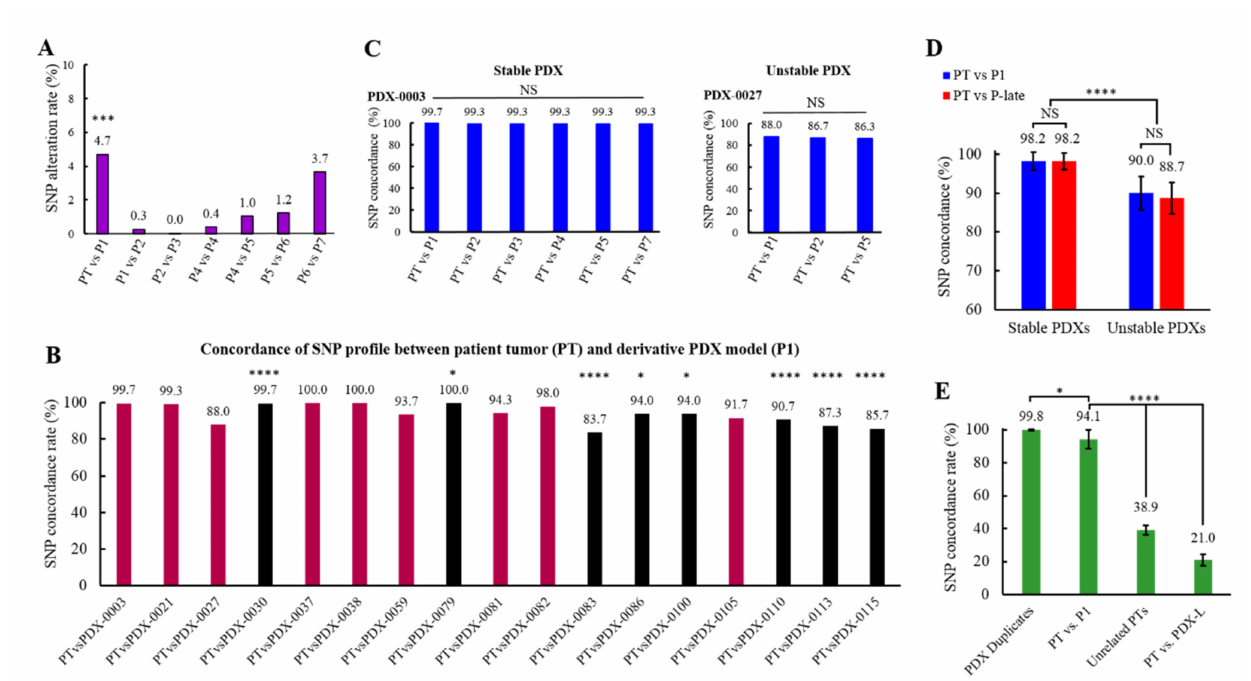
Figure 3. Analysis of genomic fidelity and stability of PDX models. ( A ) Graph represents SNP alteration rate in 17 PDX models across passages (pooled data are shown). Each column represents the percentage of altered SNPs between patient tumor (PT) and the consecutive PDX passage (P); (Dunnett’s test). ( B ) Graph represents a SNP concordance within each PDX by comparing originating patient’s tumor and the first PDX passage (P1). Genetically unstable PDXs are denoted by black columns (Dunnett’s test). ( C ) Comparison of SNP concordance between genetically stable and unstable PDXs presented as percentage of matching SNPs between original patient tumor and derivative PDX passages (one-way ANOVA followed by Tukey’s multiple comparisons test). ( D ) SNP concordance between patient’s tumor (PT) and initial (P1) or late (P-late) PDX passage that was evaluated in stable vs. unstable PDXs (one-way ANOVA followed by Tukey’s multiple comparisons test). ( E ) Graph shows an average SNP concordance of 17 PDXs at the time of PDX initiation (PT vs. P1), PDX duplicate samples, unrelated patients’ samples and lymphoma contaminated PDXs (one-way ANOVA followed by Tukey’s multiple comparisons test). ( A – E ) Data are represented as mean ± SEM. The following symbols indicate the statistical significance of data: NS = not significant, * = p < 0.05, *** = p < 0.001 and **** = p < 0.0001. For additional information, see Supplementary Figure